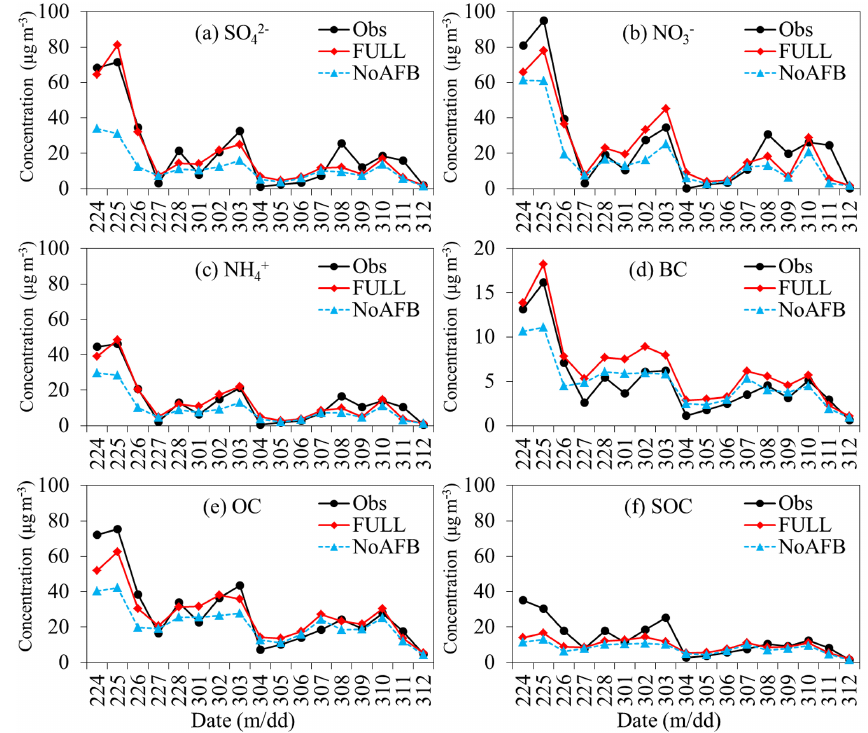
Figure 3. The model-simulated and observed daily-mean concentrations of aerosol compositions in PM 2 . 5 at the IAP site in